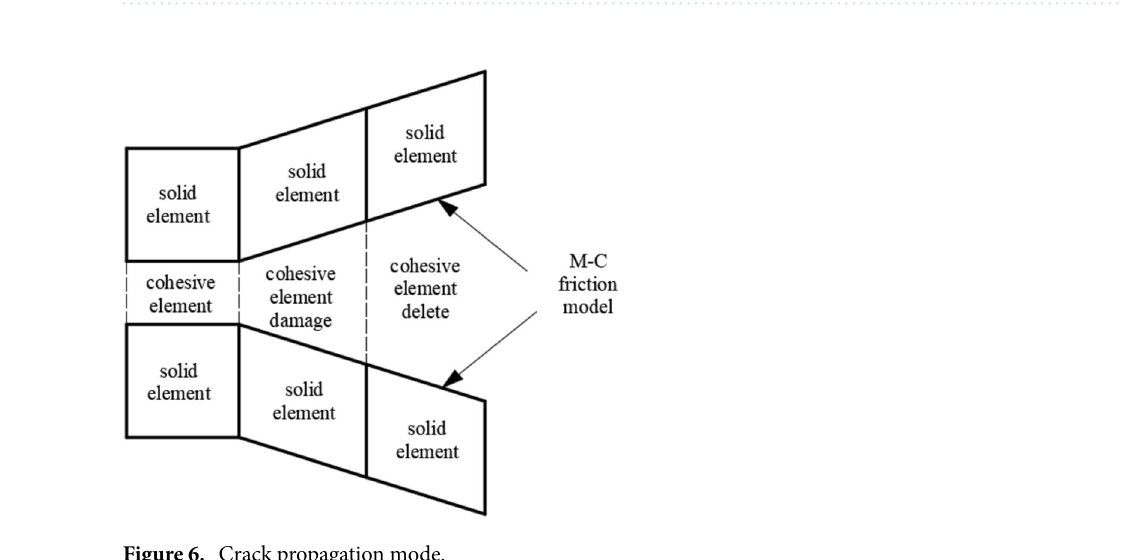
Table 1. CZM model parameter. “*”Represent repeated trial calculation value.